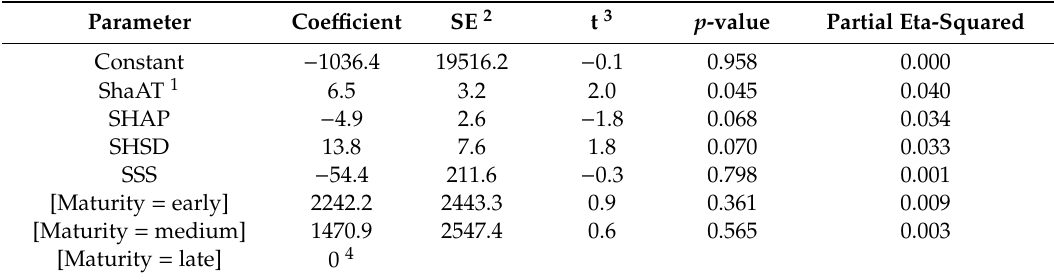
Table 5. Results of general linear model for sorghum–sudangrass hybrid including climatic